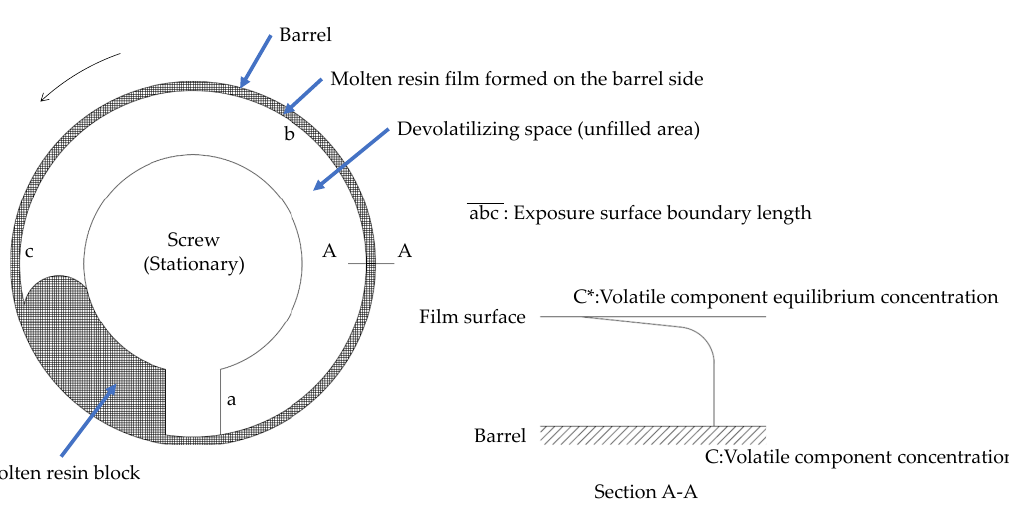
Figure 1. Schematic illustration of Latinen’s model for devolatilization in a single-screw extruder. The time-averaged mass transfer coe ffi cient was obtained by integrating Equation (1) with respect to exposure time θ and dividing it by θ